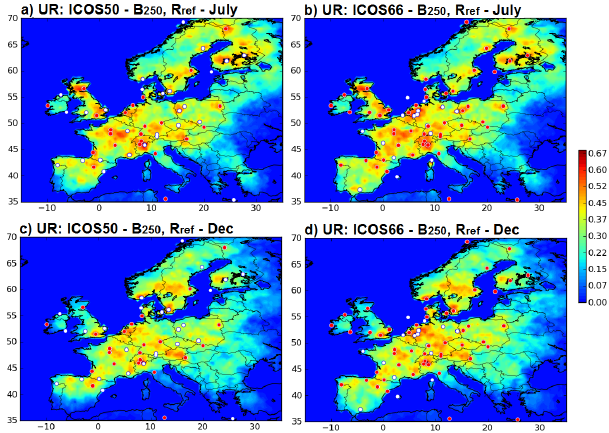
Figure 7. Uncertainty reduction (theoretically comprised between 0 and 1) for a 2-week-mean NEE at 0.5 ◦ resolution in July (a, b) and December (c, d) when using ICOS50 (a, c) and ICOS66 (b, d) and the reference inversion configuration. Red dots corresponds to the ICOS23 (a, c) or ICOS50 (b, d) sites while white dots correspond to the additional sites included in ICOS50 or ICOS66, respectively. Red/blue colors indicate relatively high/low uncertainty reduction (with min = 0 and max = 0.68 in the color scale).